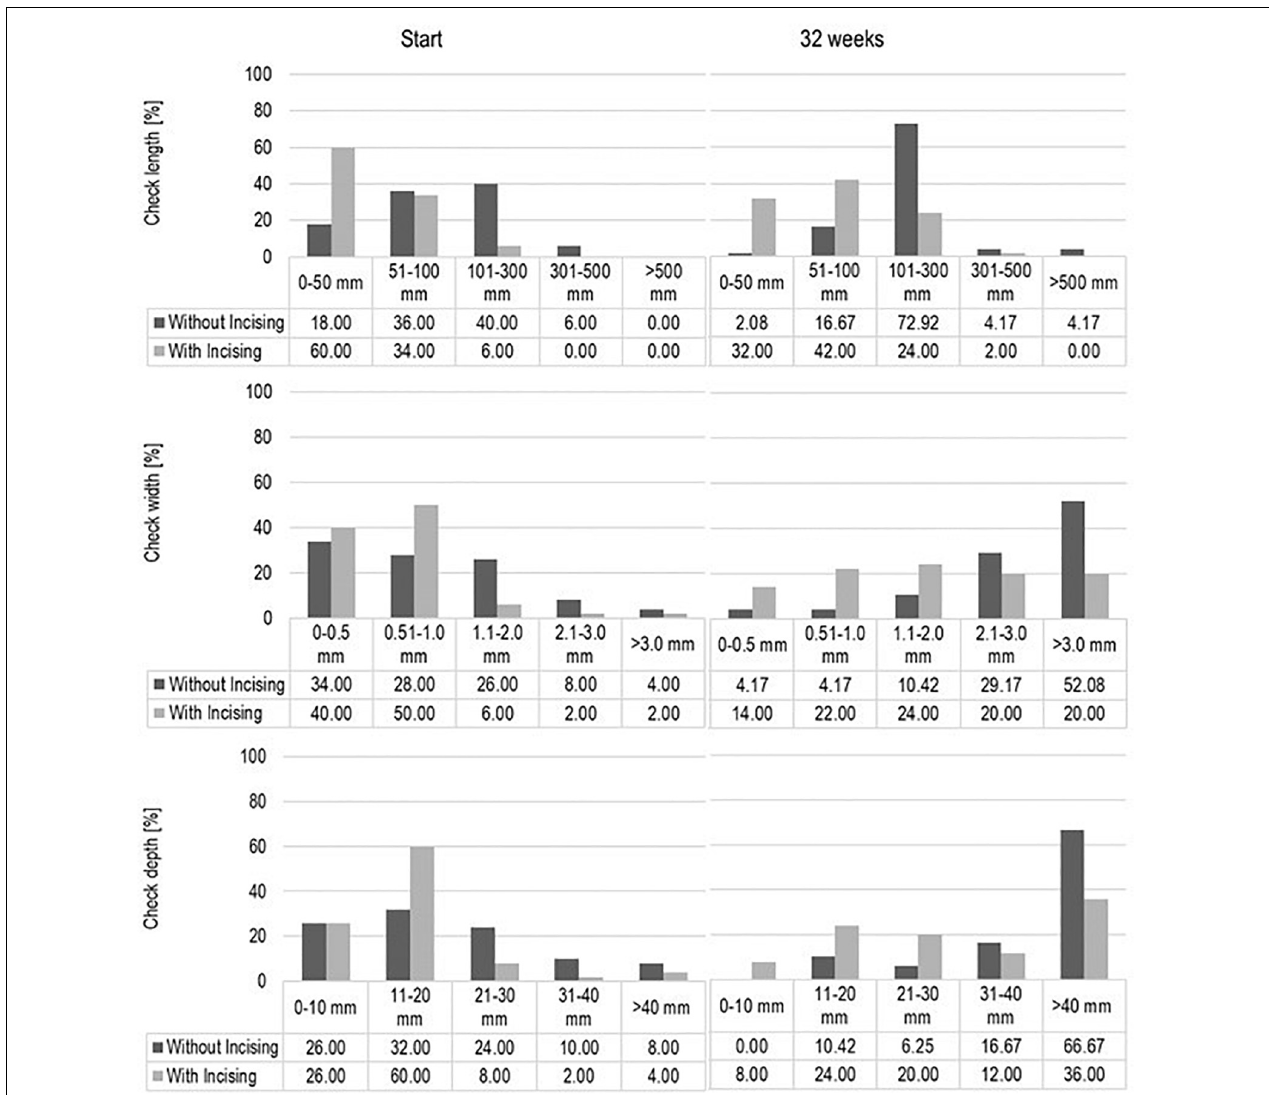
FIGURE 5 | Check length, width and depth (mm) in Beech sleepers with and without incising at the start and after 32 weeks of seasoning.